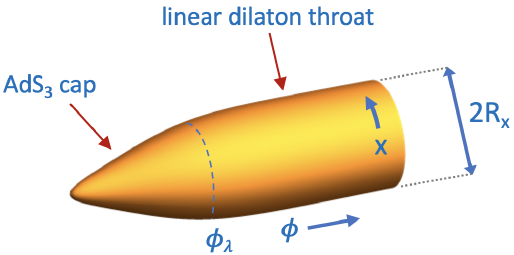
Figure 3. Sketch of the deformed geometry, showing the spatial geometry on a fixed time slice (suppressing the S 3 directions). The growth of the azimuthal circle in AdS [ R x at a radial scale φ ≈ φ λ , where the geometry rolls over to a constant size circle and linear dilaton in φ